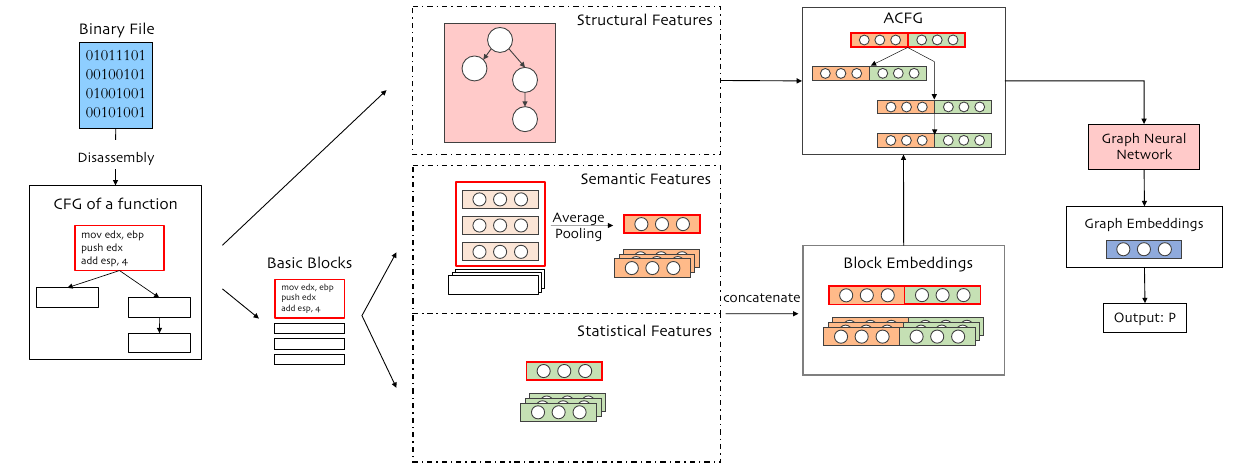
Figure 2. The overall structure of SAViP. Semantic features are extracted by a pre-trained language model. Block embedding is the concatenation of semantic and statistical features. The structural feature is utilized in the graph neural network. Output P is the vulnerable probability of a